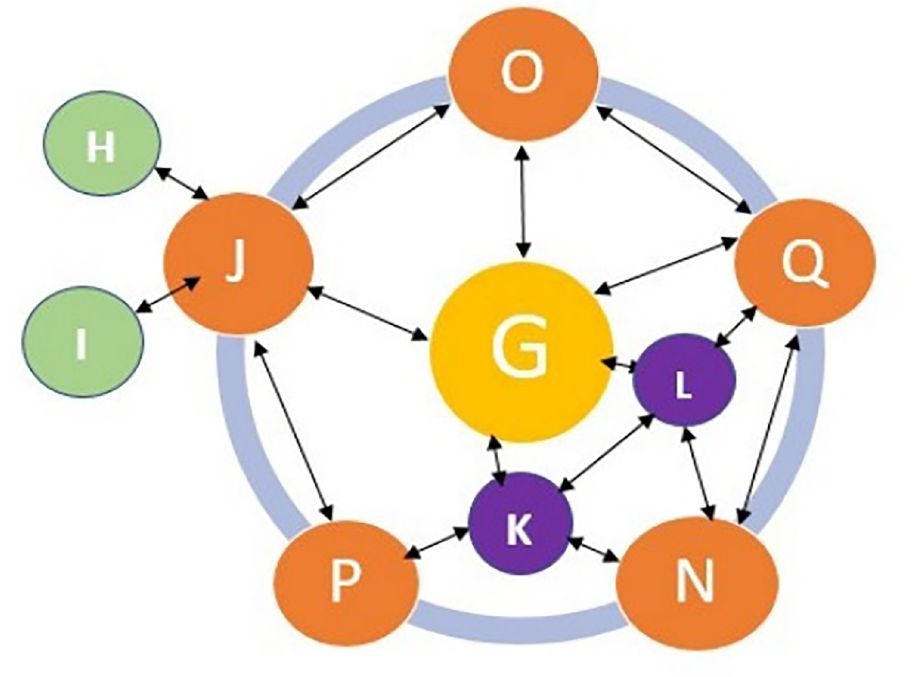
Fig 2. Zone routing of dynamic switching of the